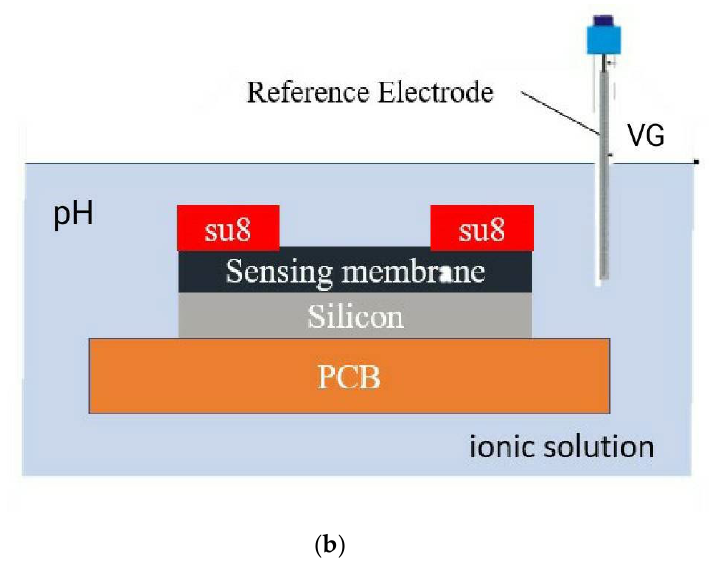
Figure 1. ( a ) The Y-doped WO 3 of EIS structure ( b ) The device under operation.